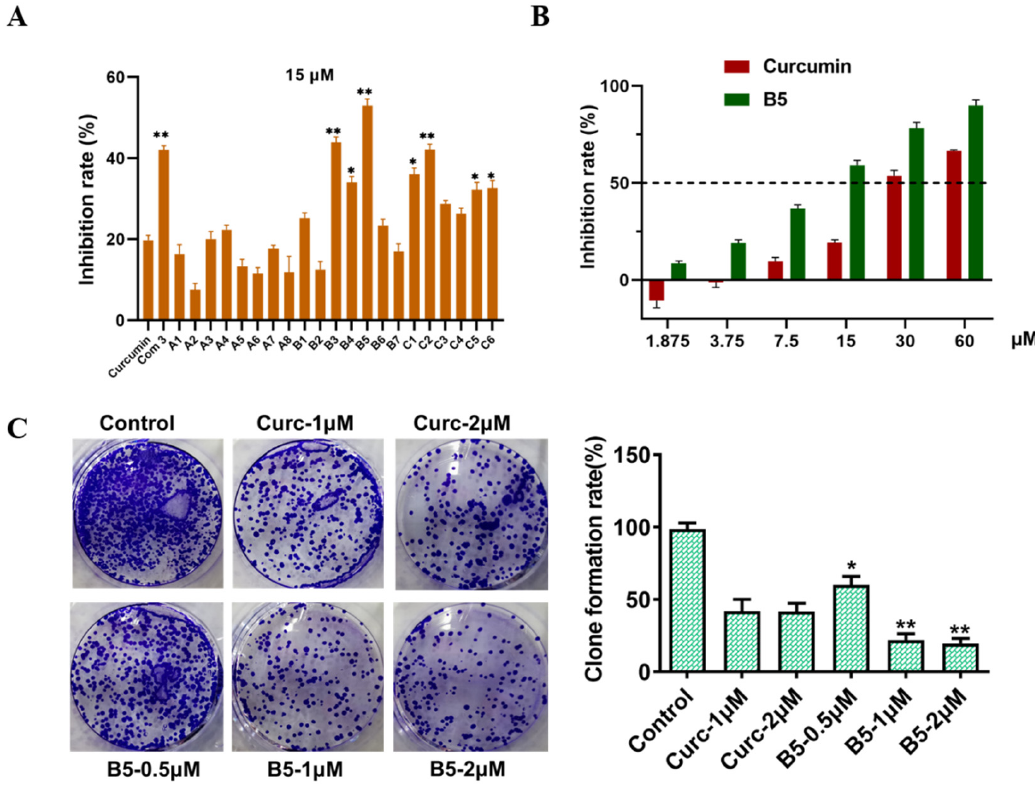
Figure 1. Anti-proliferation assay to HepG2 cells in vitro. ( A ) Curcumin analogs at the concentration of 15 μ M for 48 h. ( B ) B5 at the different concentrations (1.875, 3.75, 7.5, 15, 30, 60 μ M) for 48 h. ( C ) Clone formation assay to HepG2 cells treatment with DMEM medium containing the indicated con- centrations (0.5, 1, 2 μ M) of curcumin and B5 for 2 weeks. Data are represented by the mean ± SD of the three independent experiments. ** p < 0.01, * p < 0.05, compared with the control group.